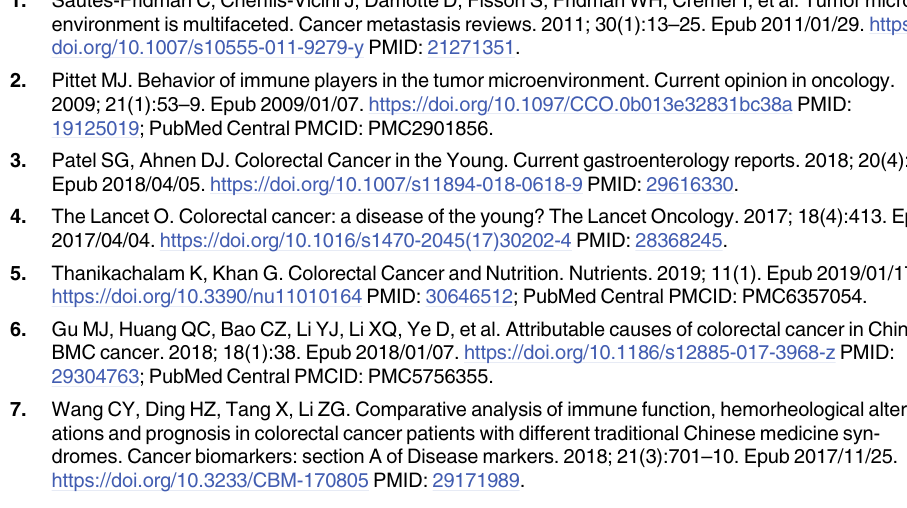
S1 Table. Basic information of some active components of